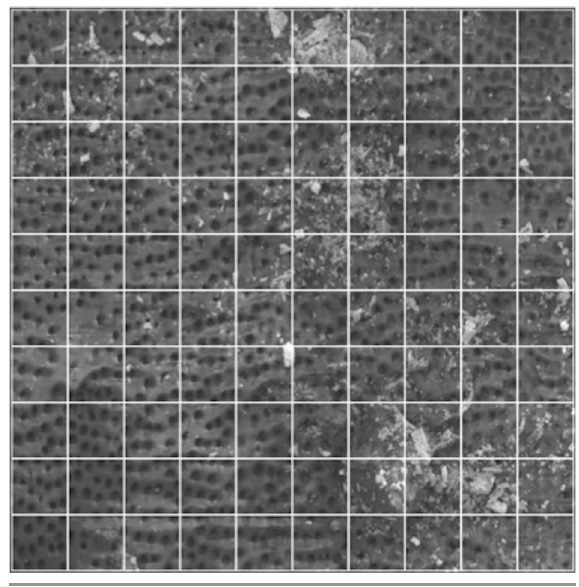
Figure 2. Representative preoperative image of a sample before irrigant activation with the digital grid overlapped that is used for quantification of clean areas. The picture shows that remnant filling material persisted in some areas after the reinstrumentation in the retreatment